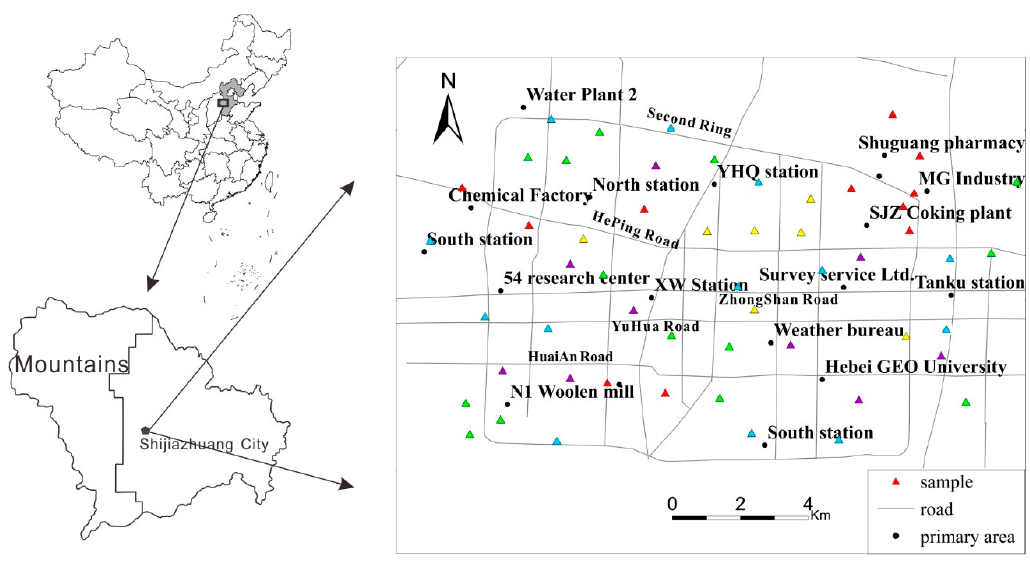
Figure 1. Map of sampling points in Shijiazhuang City. Green, yellow, red, purple, and blue triangles represent residential, commercial, industrial, office, and traffic areas, respectively.